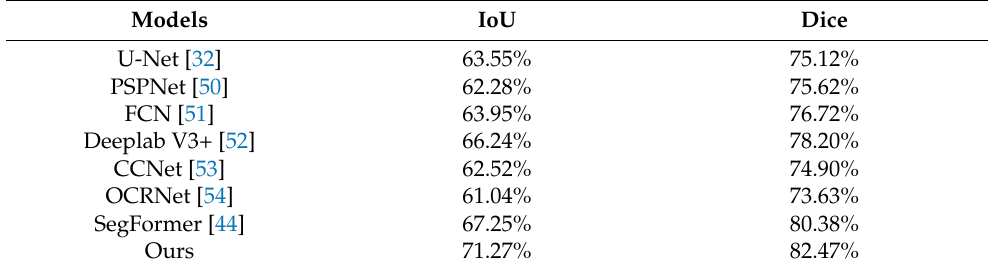
Table 6. Comparison of the segmentation results of our model and other models on the testing set.